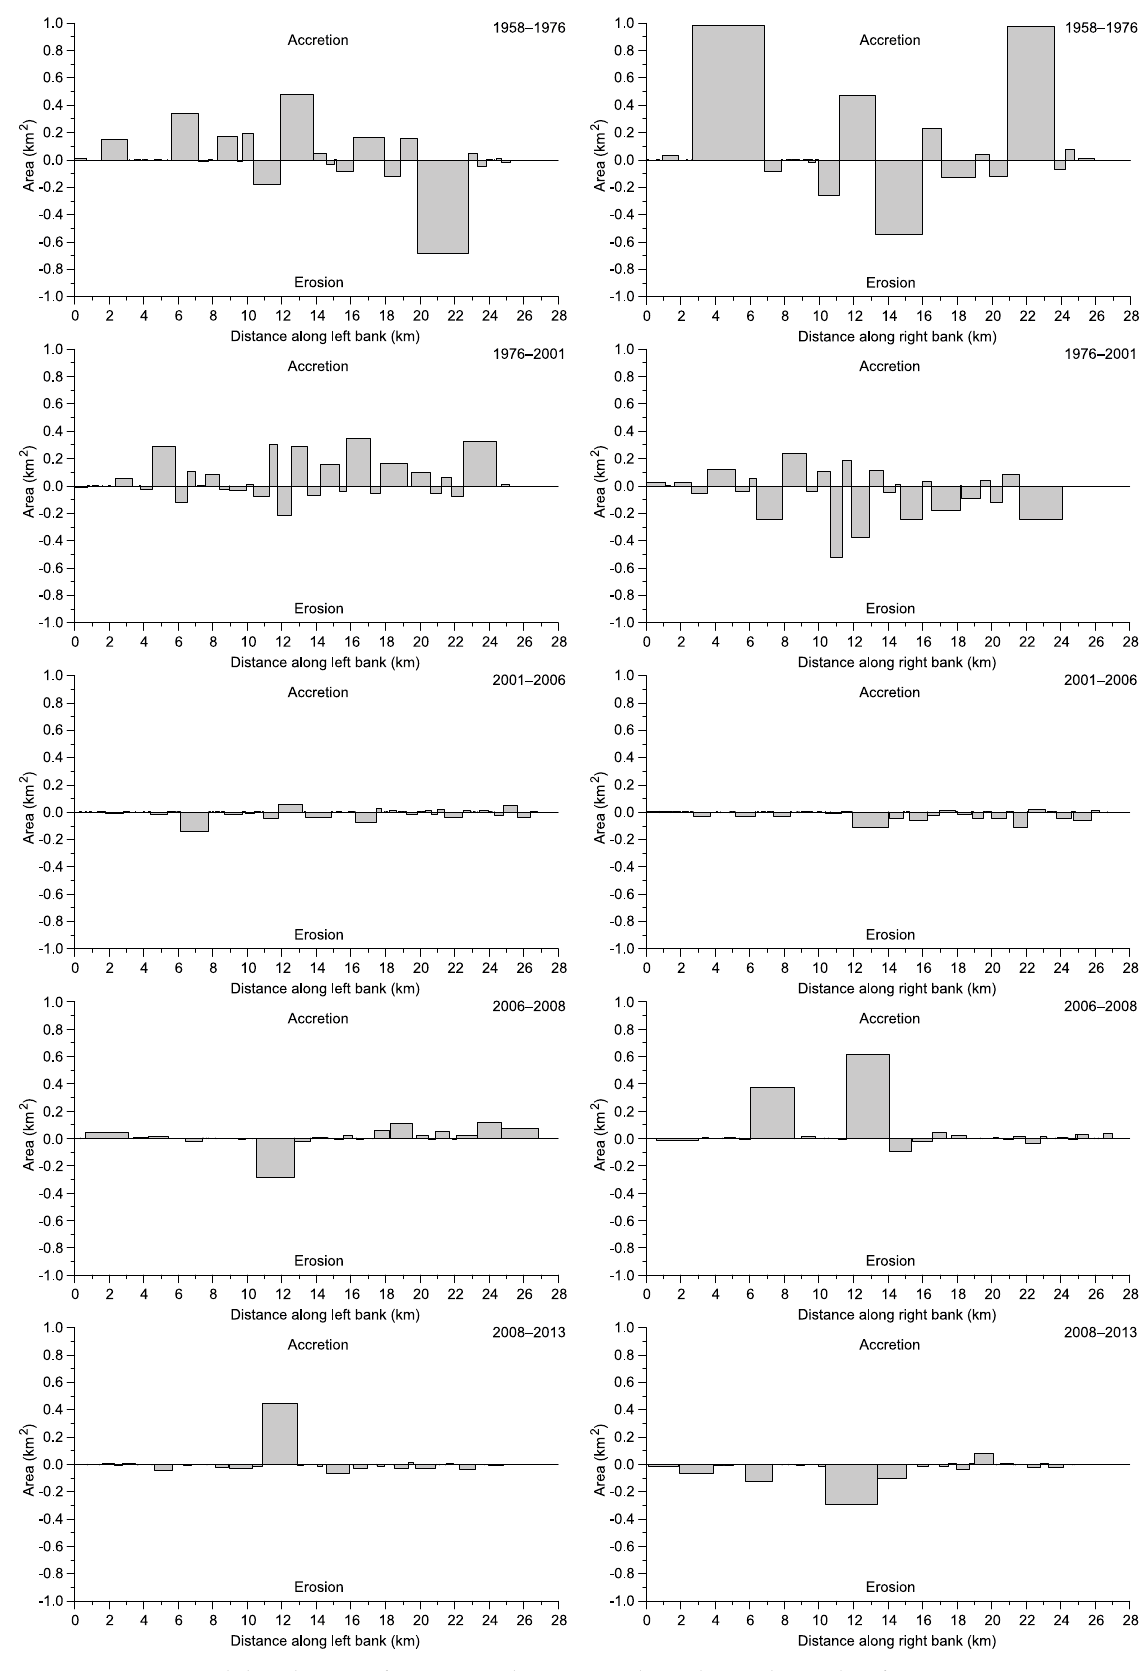
Fig. 3. Spatial distribution of erosion and accretion along the study reaches from 1958 to